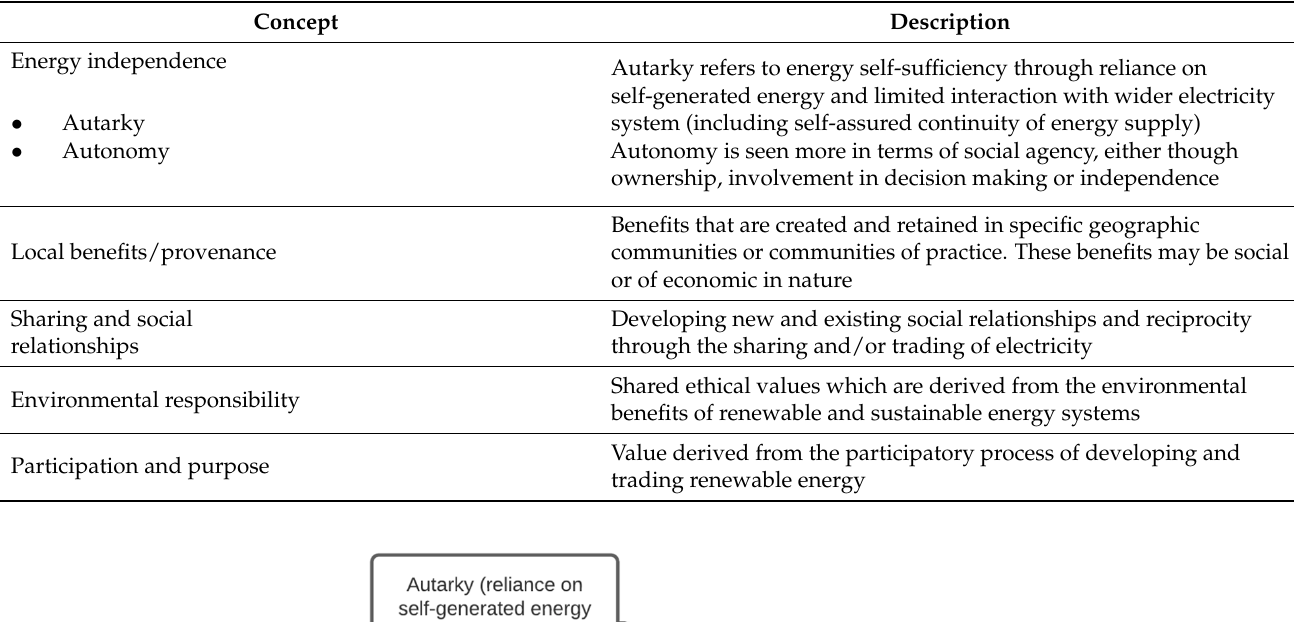
Table 3. Summary of social value dynamics of P2P, CSC and TE models.